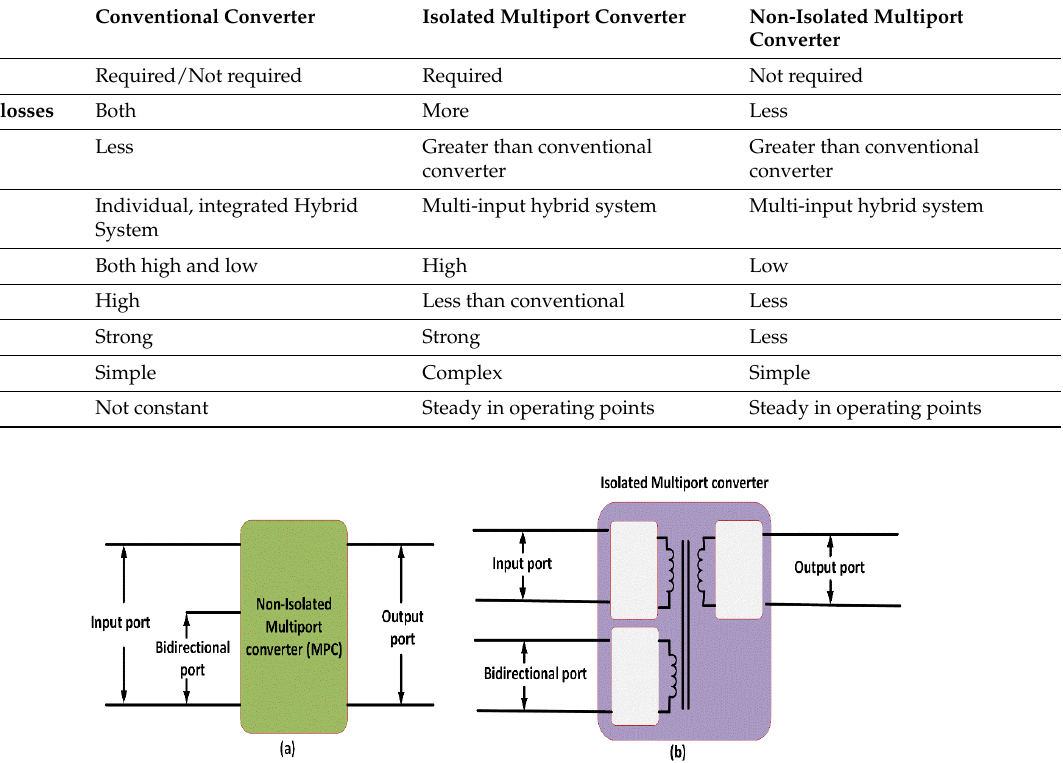
Figure 3. The typical schematic structure of a multiport converter, ( a ) non-isolated and ( b ) isolated. Table 1. Comparative analysis of the different DC-DC converter topologies [3].